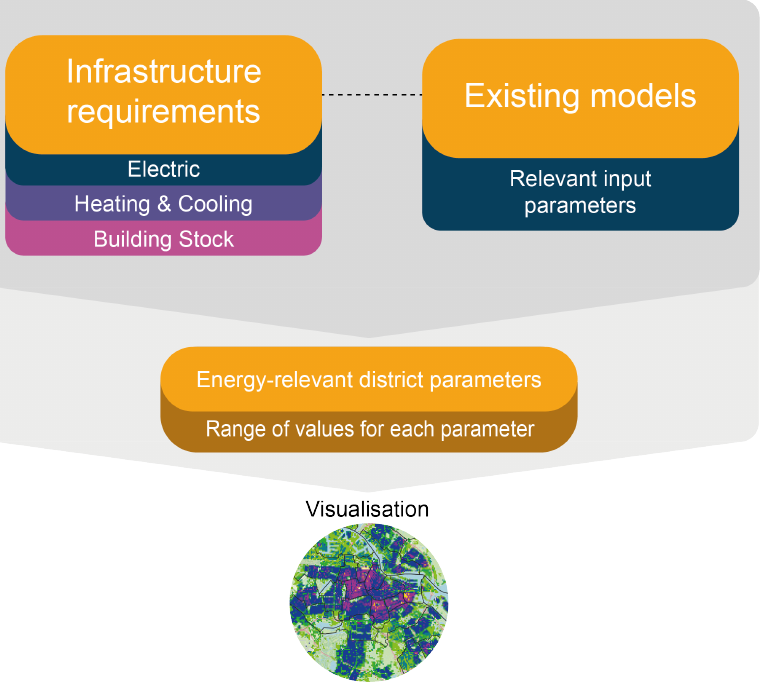
Figure 2. Our methodological approach to classifying districts from an energy modelling point of